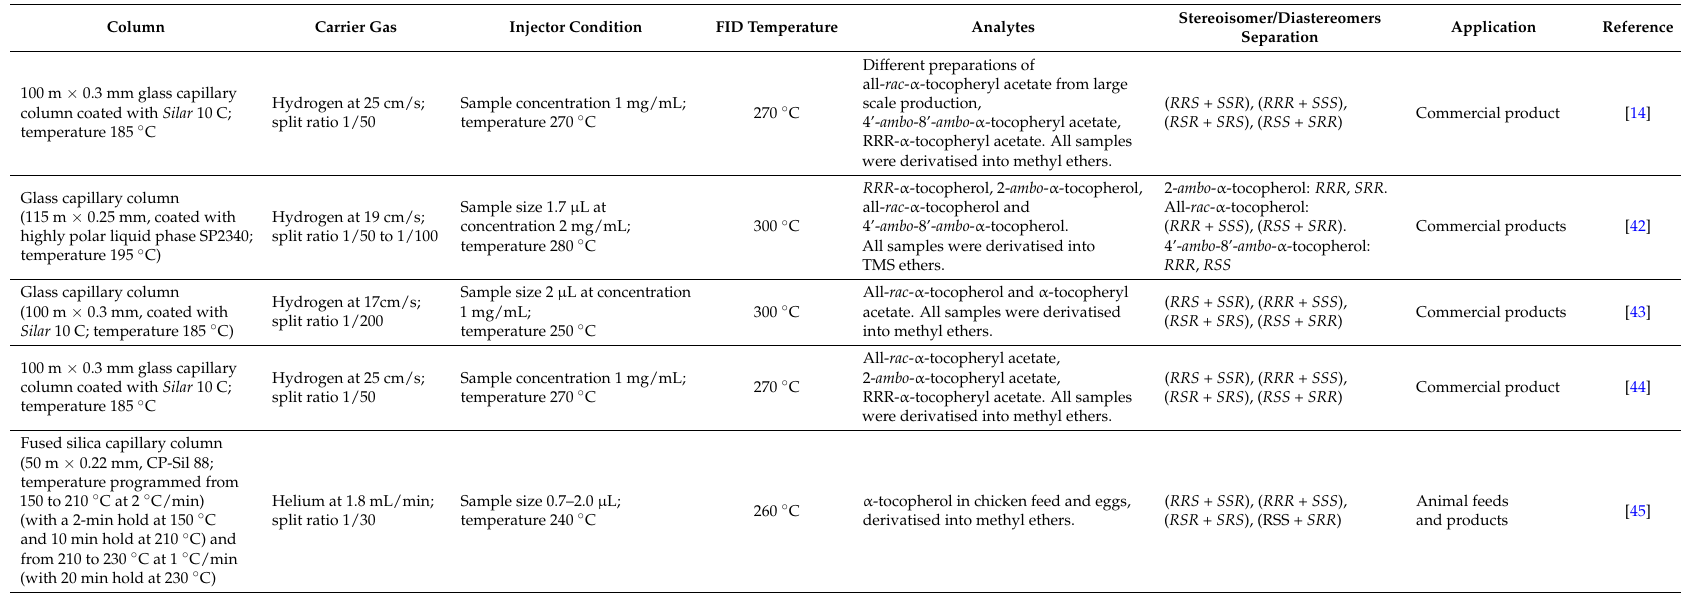
Table 2. GC methods for α -Toc